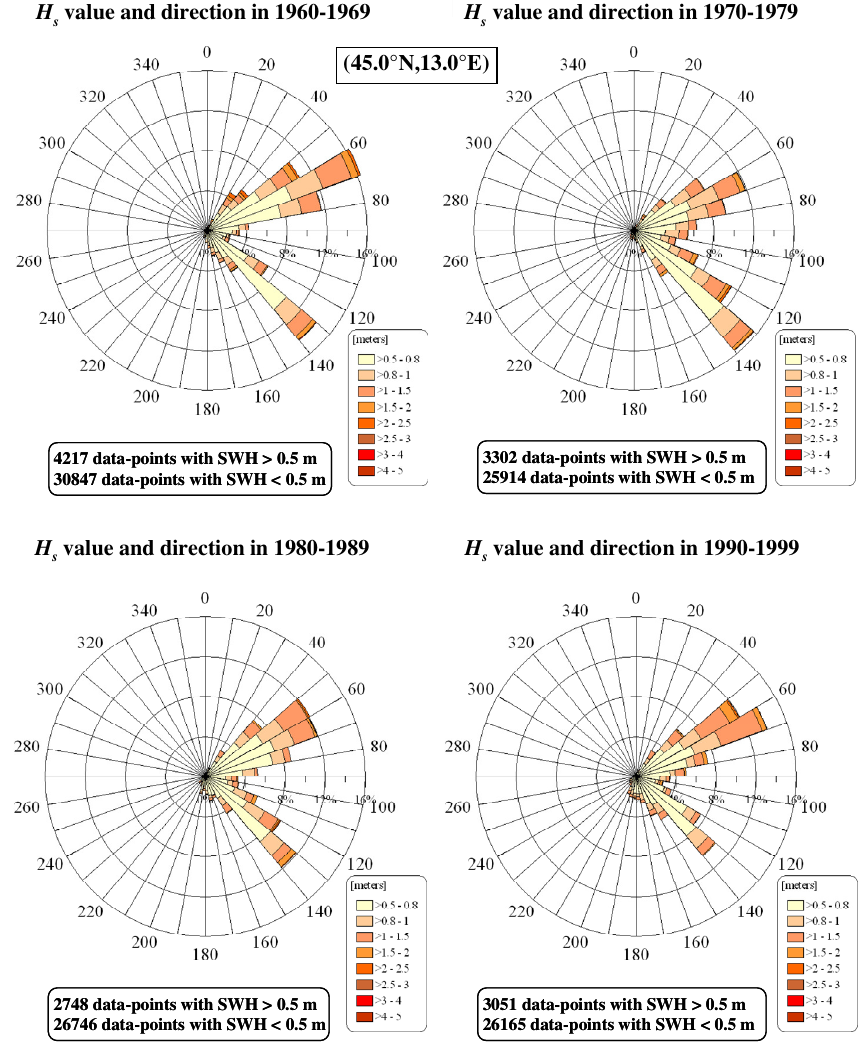
Fig. 4. Decennial rose diagrams from 1960 to 1999 of significant wave heights and relative frequencies of occurrence at (45.0 ◦ N, 13.0 ◦ E). The H s values are filtered for heights < 0.5 m.